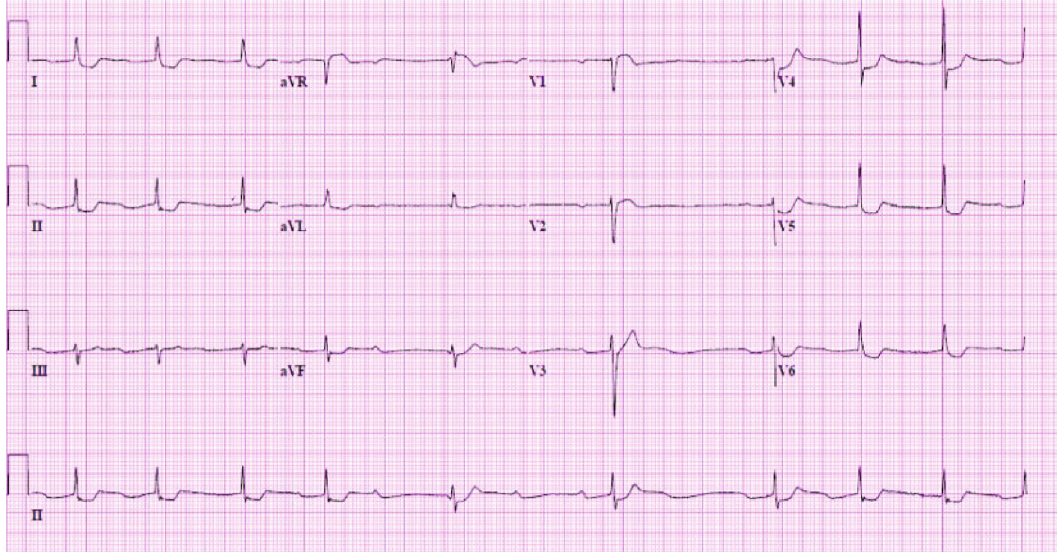
Figure 1: ECG at presentation showed normal sinus rhythm with ST elevation in lead aVR and ST depressions in multiple leads with high- degree atrioventricular (AV) block. ECG: